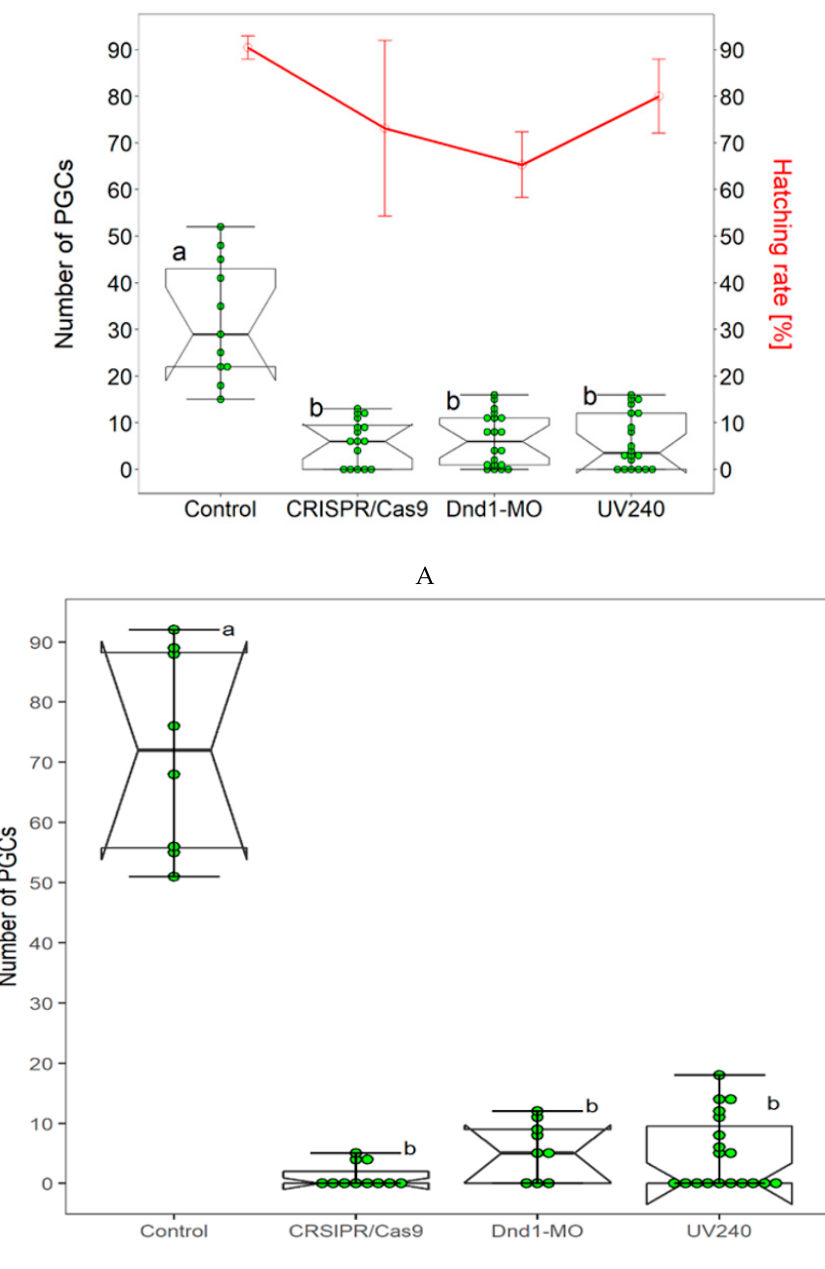
Figure 2. Three di ff erent methods to achieve sterility in sterlet ( Acipenser ruthenus ) have been established and were compared. ( A ): The control and embryos injected with CRISPR / Cas9, Dnd1 -MO and UV240 exposed embryos; injected with FITC-dextran to label PGCs. Number of PGCs were counted in all three treated groups i.e., CRISPR / Cas9, Dnd1 -MO and UV240, and in control group. FITC-labeled PGCs were found to be reduced at the neurula to tail bud stage (box plots). Hatching and survival rates were found to be lower in Dnd1 -MO embryos (line graph) when compared to the control group. In CRISPR / Cas9 and UV240 irradiation method, hatching and survival rates of embryos did not significantly vary (line graph). The survived embryos from all three treated groups were kept and FITC-labeled PGCs were observed at 22 dpf. Number of FITC labeled PGCs continued to be absent in CRISPR / Cas9, Dnd1 -MO and UV240 groups, while larvae from the control group have many FITC-labeled PGCs in the gonadal region ( B ). Bars with di ff erent letters signify a significant di ff erence ( p < 0.05).